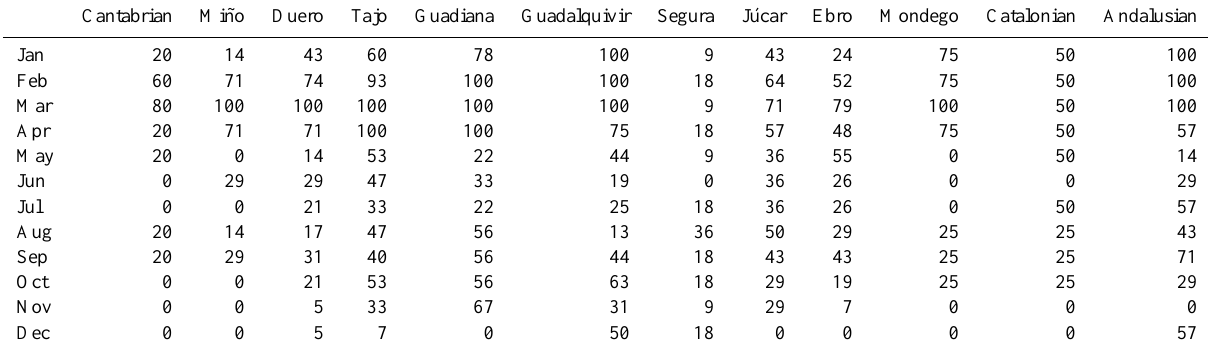
Table 1. Percentage of gauging stations which registered significant anomalies differences between positive and negative NAO phases. Cantabrian Mi˜no